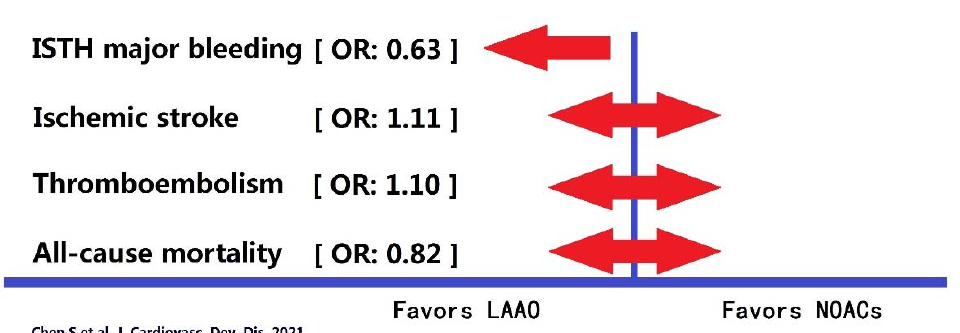
Figure 2. Graphic summary of the present study.